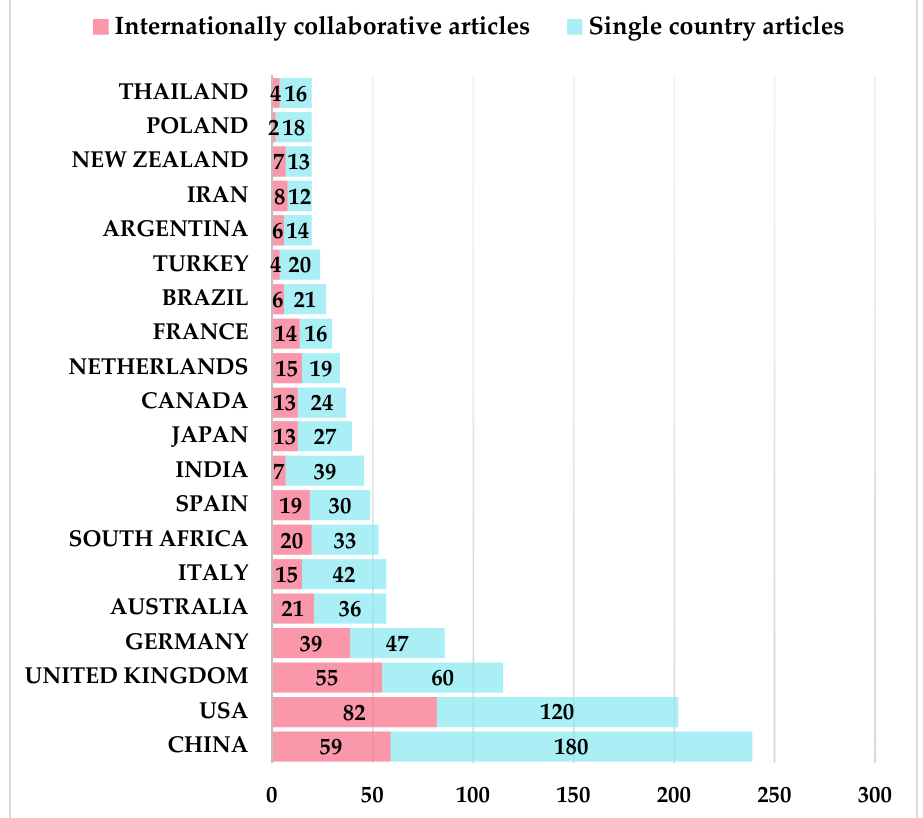
Figure 9. Corresponding authors’ nationalities in the 20 most-prolific countries in the field of land degradation.